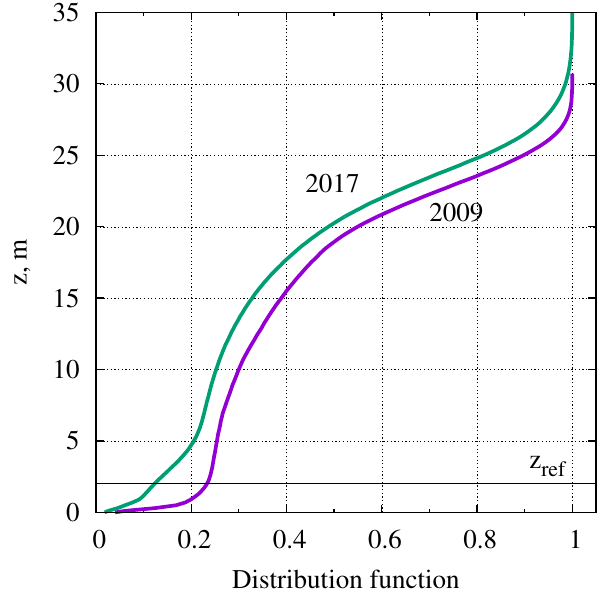
Figure 4. Distribution function of ALS hits in the RAMI birch stand in 2009 and